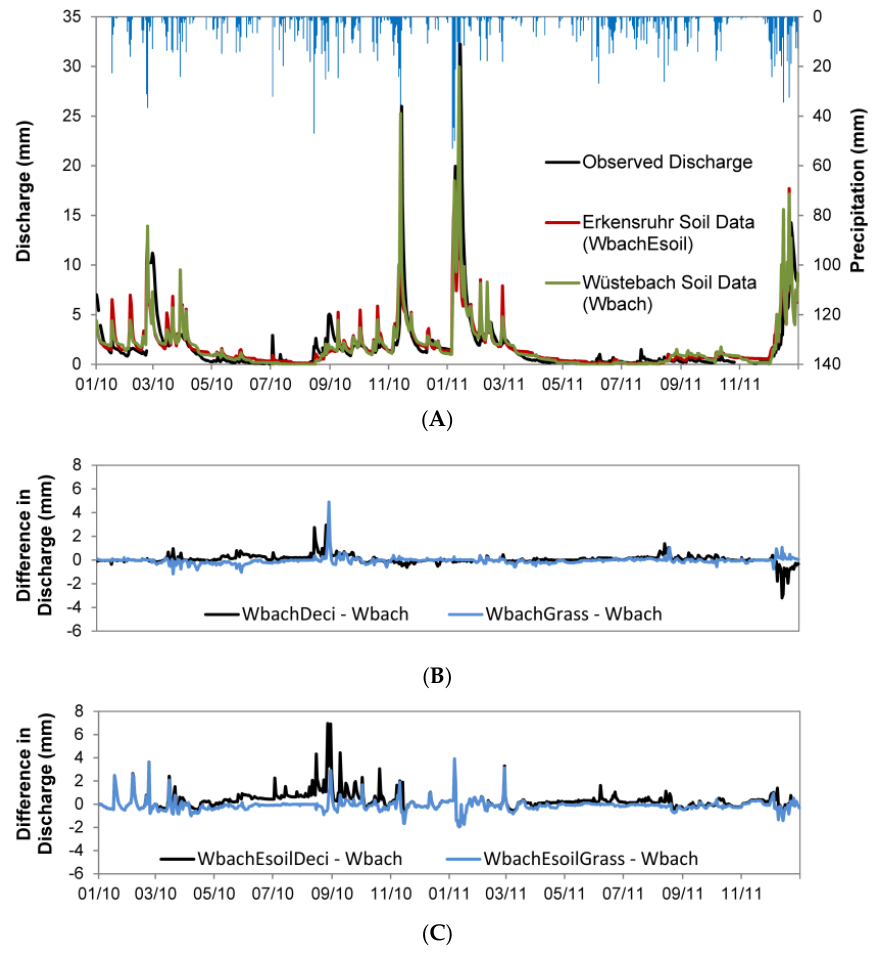
Figure 2. ( A ) Comparison of observed and simulated discharge of the Wüstebach for simulations with high-resolution soil data (Wbach) and low-resolution soil data (WbachEsoilConi); ( B ) Discharge difference between simulations with changing land use; ( C ) Discharge difference between simulations with changing land use and soil data.